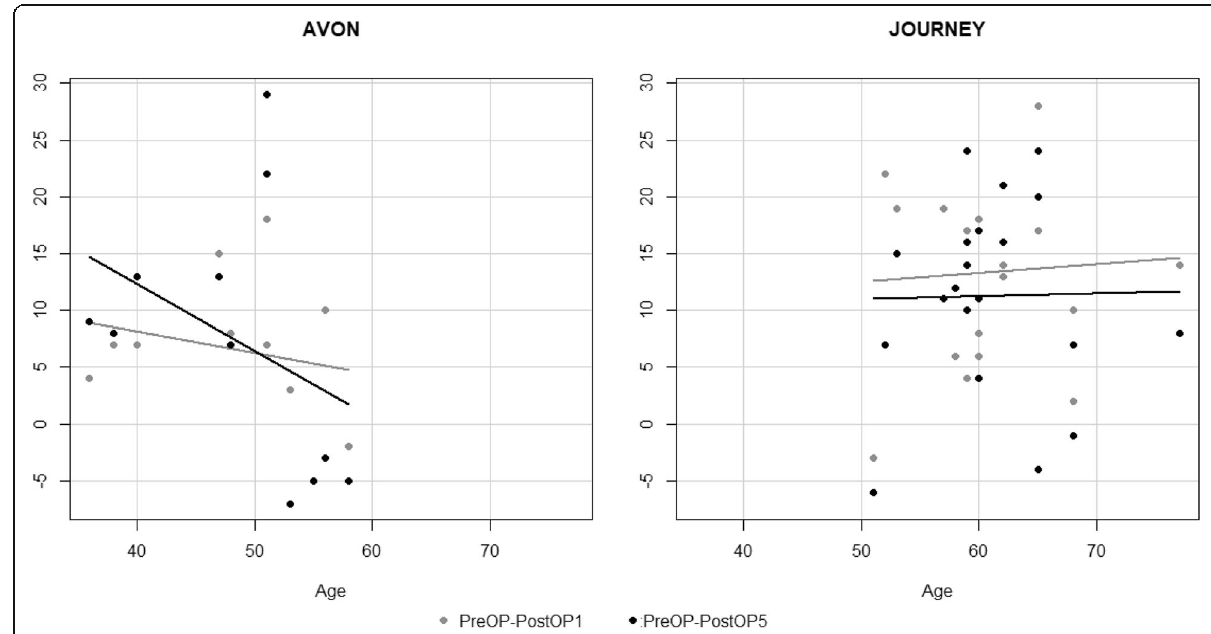
Fig. 4 Postoperative OKS improvement in relation to the age among the two different implant types